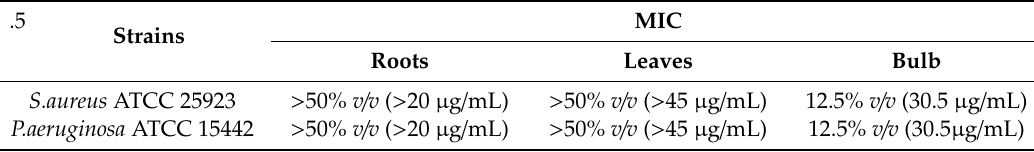
Table 1. Minimum inhibitory concentration (MIC) of the three samples from different parts of C. pancration.